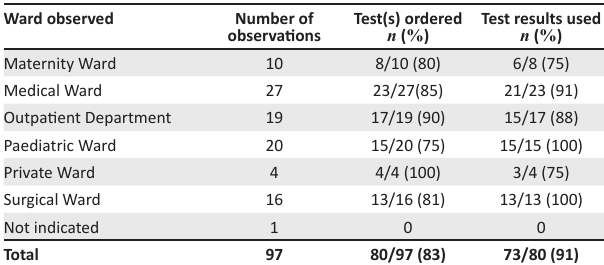
TABLE 7: Clinician observations, Malawi, October-November